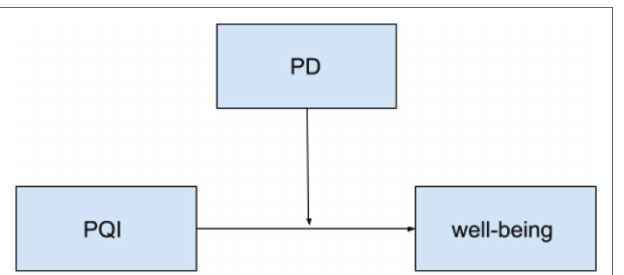
FIGURE 4 | Hypothesized two-way moderation model between income and PD on well-being for both